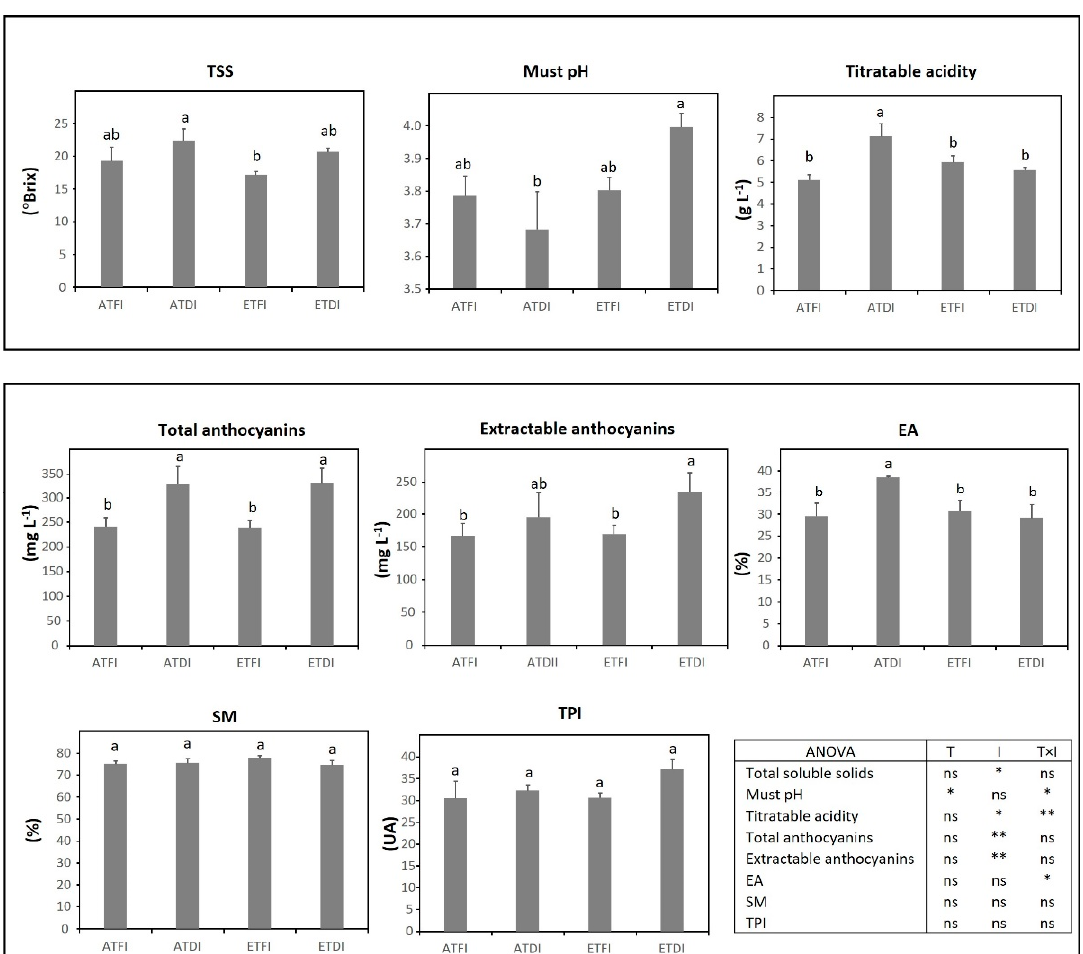
Figure 4. Grape technological and phenolic maturity assessed at harvest in fruit-bearing cuttings of Tinto Velasco (TV) grown either at ambient (AT) or elevated temperature (ET) and subjected to different irrigation regimes (FI, full irrigation; DI, deficit irrigation). Values are means ± S.E. ( n = 5). Bars topped by the same letter do not differ significantly ( p > 0.05) according to Duncan’s test. Significance of the analysis of variance (ANOVA): * p < 0.05; ** p ≤ 0.01; ns, not significant ( p ≥ 0.05). TSS, total soluble solids; TPI, total polyphenol index; EA, cellular extractability of anthocyanins; SM, seed maturity; AU, absorbance units.